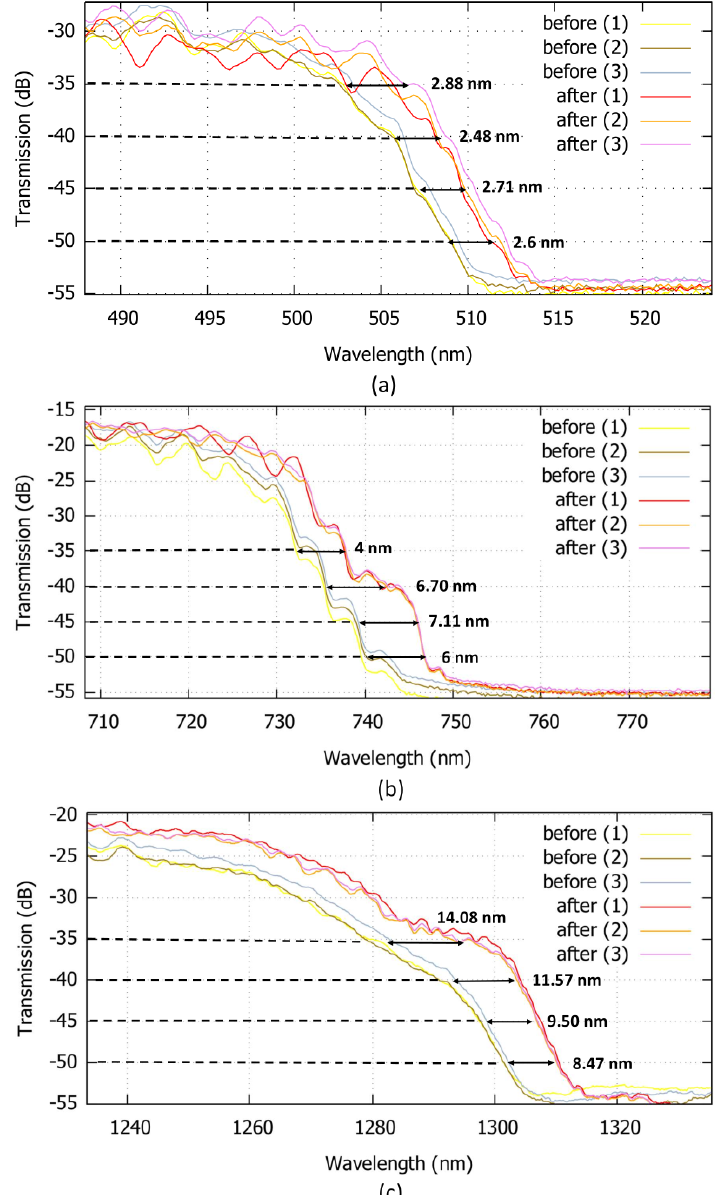
Figure 7. Zoomed images of the high loss regions at the reference level of − 35 dB, − 40 dB, − 45 dB, and − 50 dB, in different wavelength ranges of ( a ) 500–520 nm, ( b ) 720–750 nm, and ( c ) 1290–1320 nm. The results related to the first (1), second (2), and third (3) measurements before and after streptavidin solution infiltration, are